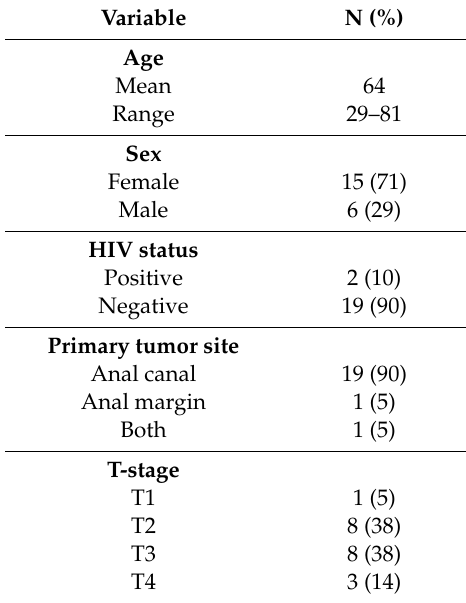
Table 2. Patient and tumor